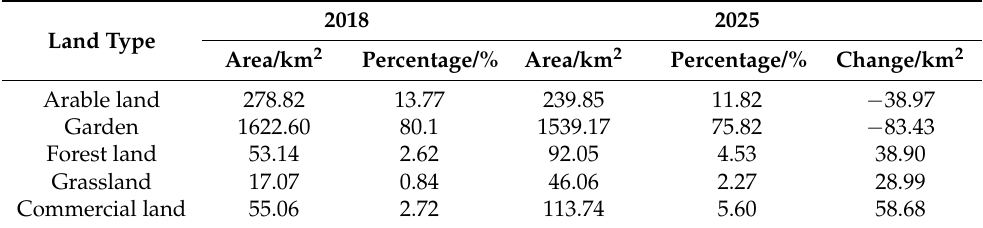
Table 8. Proportion of land use types in 2025.